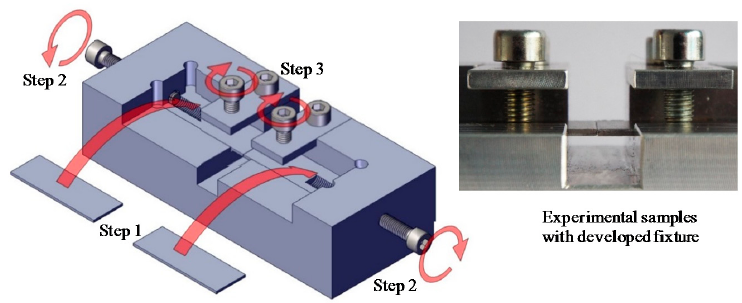
Figure 5. Design of welding sample fixture.